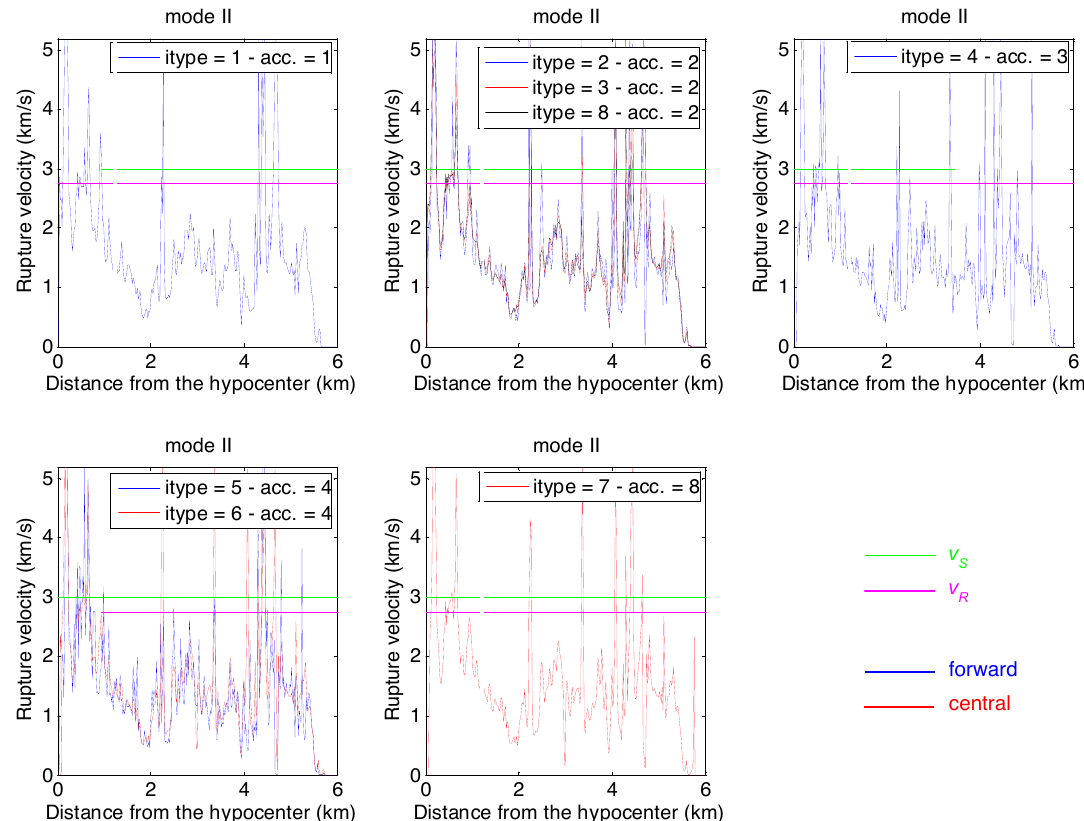
Figure 11. The same as in Figure 10, but now for a heterogeneous configuration obeying to the Ruina–Dieterich friction law (see Section 4 of the main text for further